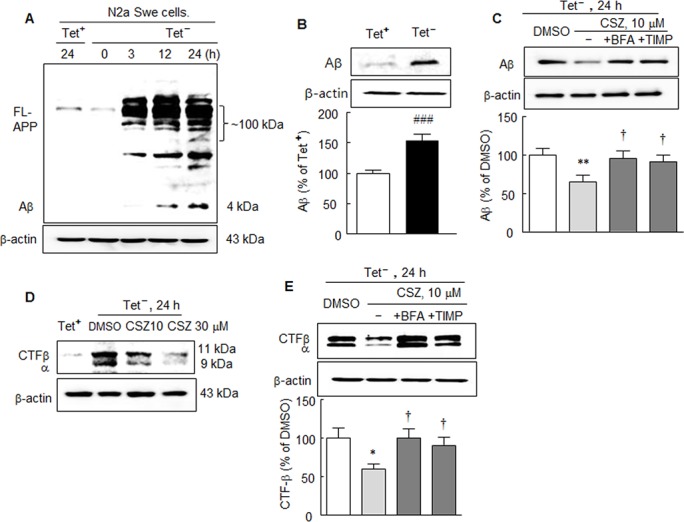
A. Time-dependent increases in the expressions of full-length APP (FL-APP) and Aβ in N2aSwe cells determined using anti-Aβ (6E10) antibody. To evoke endogenous Aβ overproduction, cells were exposed to medium containing 1 μg/ml of tetracycline (Tet+) for 48 h and then switched to tetracycline-free medium (Tet-) for 3, 12, and 24 h. B. Aβ accumulation after culturing cells in Tet- condition for 24 h. C. Cilostazol-induced suppression of Aβ expression induced by Tet- condition, and prevention of this inhibition by bafilomycin A1 (BFA, 100 nM) and TIMP-1 (10 μM), respectively. D. Effect of cilostazol on the increased CTFβ (11 kDa) and CTFα (9 kDa) levels cultured in Tet- condition (Western blot using rabbit polyclonal CTFβ (751–770) antibody). The Western blots shown are representative of four independent experiments that yielded similar results. E. Prevention by bafilomycin A1 (BFA, 100 nM) and TIMP-1 (10 μM) of cilostazol-induced decreases in the CTFβ expressions.Results are the means ± SDs of percentages (N = 4). ###
P < 0.001 vs. Tet+; **P < 0.01, ***P < 0.001 vs. DMSO; †
P < 0.05 vs. cilostazol (CSZ, 10 μM) alone.